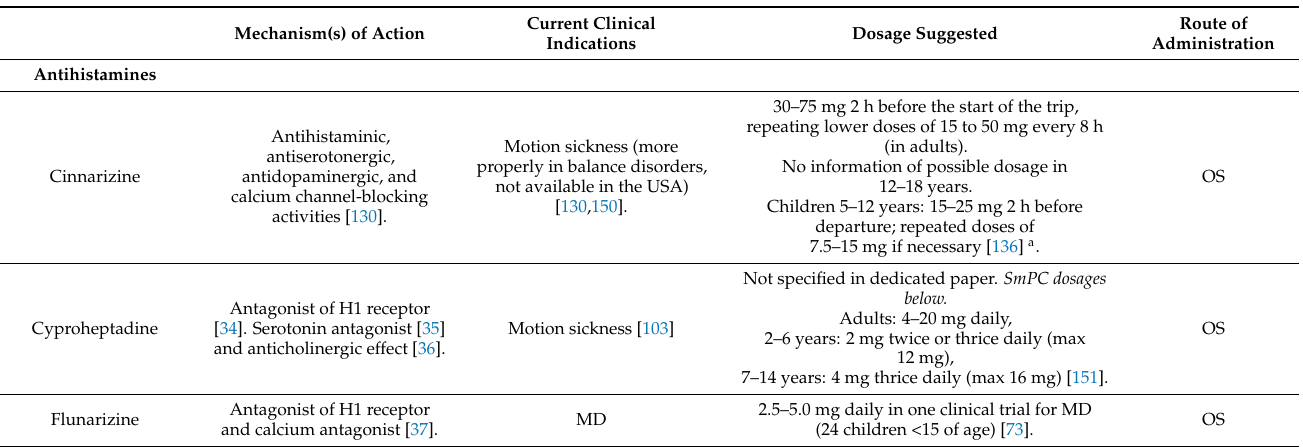
Table 6. Rationale, current clinical indications, and dosages of peripheral vestibular vertigo drugs in children (off-label compounds).